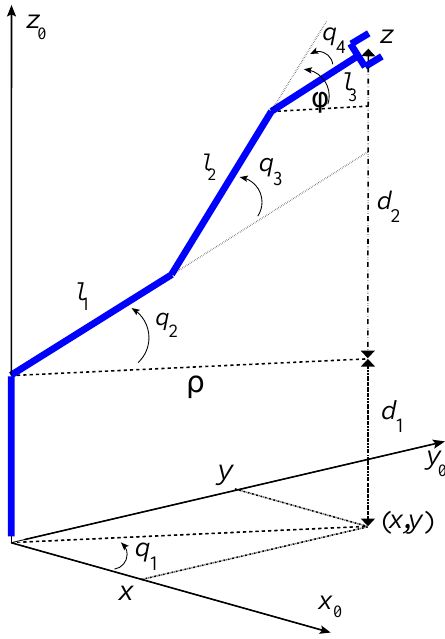
Figure 3. Kinematic scheme of the